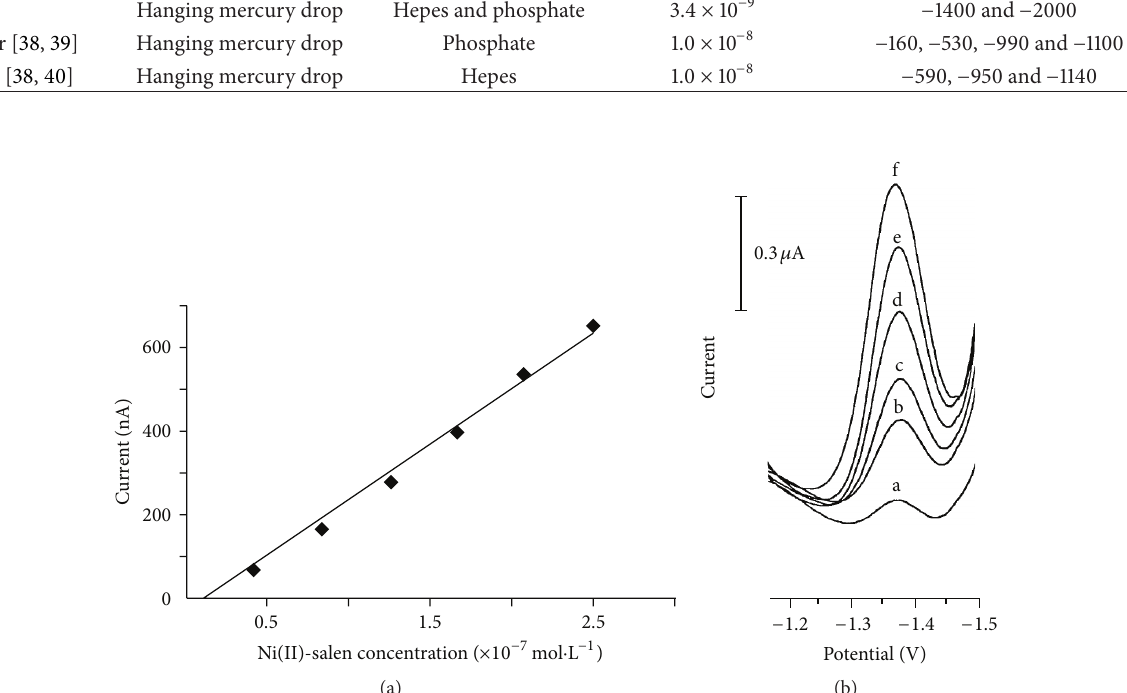
Figure 8: Square-wave stripping voltammograms (b) obtained for solutions of increasing Ni(II)-salen concentration from 4.2 × 10 −8 to 2.5 × 10 −7 molL −1 (a–f). Other conditions as in Figure 4. Also shown is the resulting calibration plot (a).